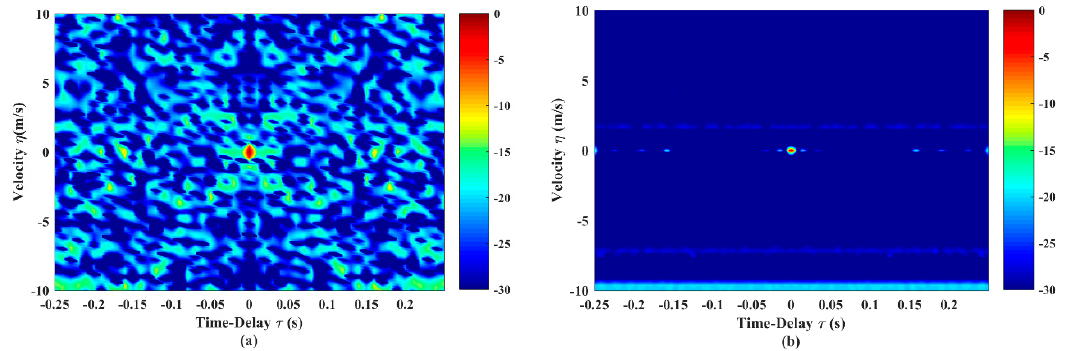
Figure 2. The AF shapes of ( a ) single generalized sinusoidal frequency-modulated (GSFM) pulse and ( b ) continuous pulse train ( N = 8). The duration of the sub-pulse t p = 0.25 s, carrier frequency f 0 = 2 KHz, and bandwidth B = 400 Hz. All sub-pulses have the identical characteristic parameters 0 α ρ ... , N n = 160, n = 2, n = 1,